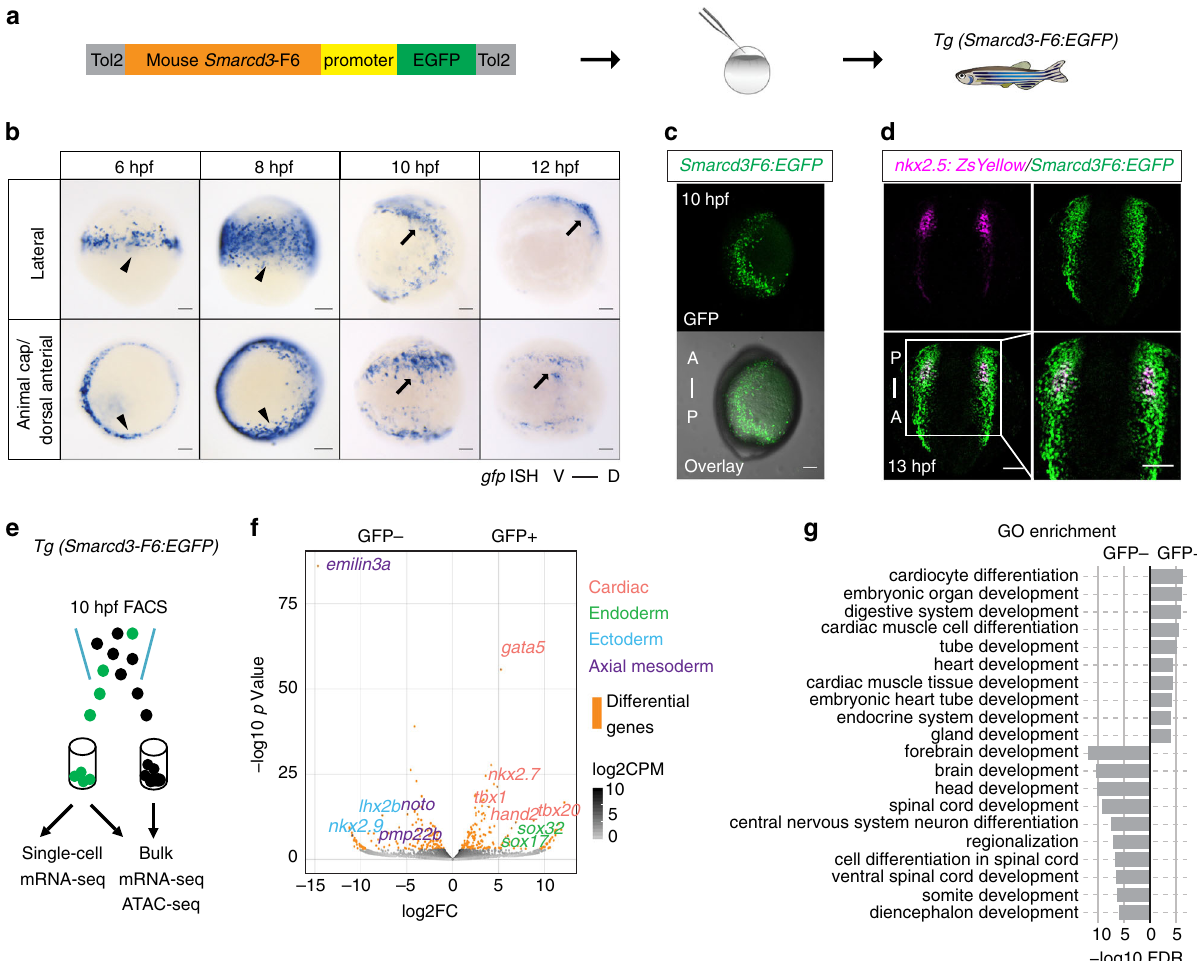
Fig. 1 Mouse Smarcd3 -F6 enhancer labels early cardiac progenitors in zebra fi sh. a Generation of Tg(Smarcd3-F6:EGFP) zebra fi sh line b In-situ hybridization against gfp transcripts on Tg(Smarcd3-F6:EGFP) transgenic embryos. Smarcd3-F6 enhancer marks lateral margins (arrowheads) during gastrulation and ALPM regions (arrows) after gastrulation. c Native GFP expression in Tg(Smarcd3-F6:EGFP) embryos at 10 hpf. Embryos are shown in lateral views. d Immunostaining of GFP and ZsYellow on Tg(Smarcd3-F6:EGFP) and Tg(nkx2.5:ZsYellow) double transgenic embryos. Cells expressing ZsYellow were marked by GFP as well. e Work fl ow of mRNA-seq and ATAC-seq experiments. f Volcano plot showing genes differentially expressed between Smarcd3-F6 : GFP + and Smarcd3-F6 :GFP- populations (FDR < 0.05, absolute log2FC > 1). g Top 10 most enriched GO terms obtained from genes that were signi fi cantly more highly expressed in Smarcd3-F6 :GFP + or Smarcd3-F6 :GFP- populations. All scale bars represent 100 μ